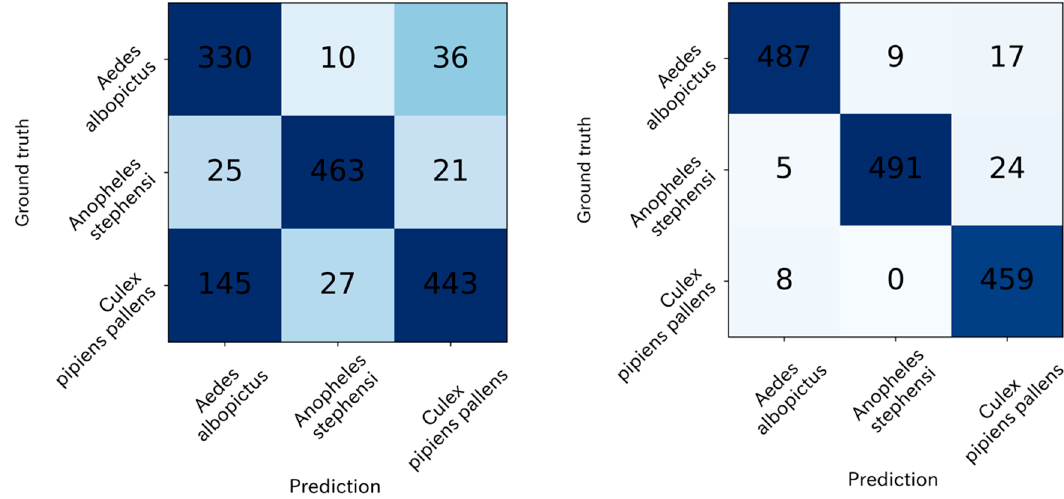
Figure 7. Example results of the confusion